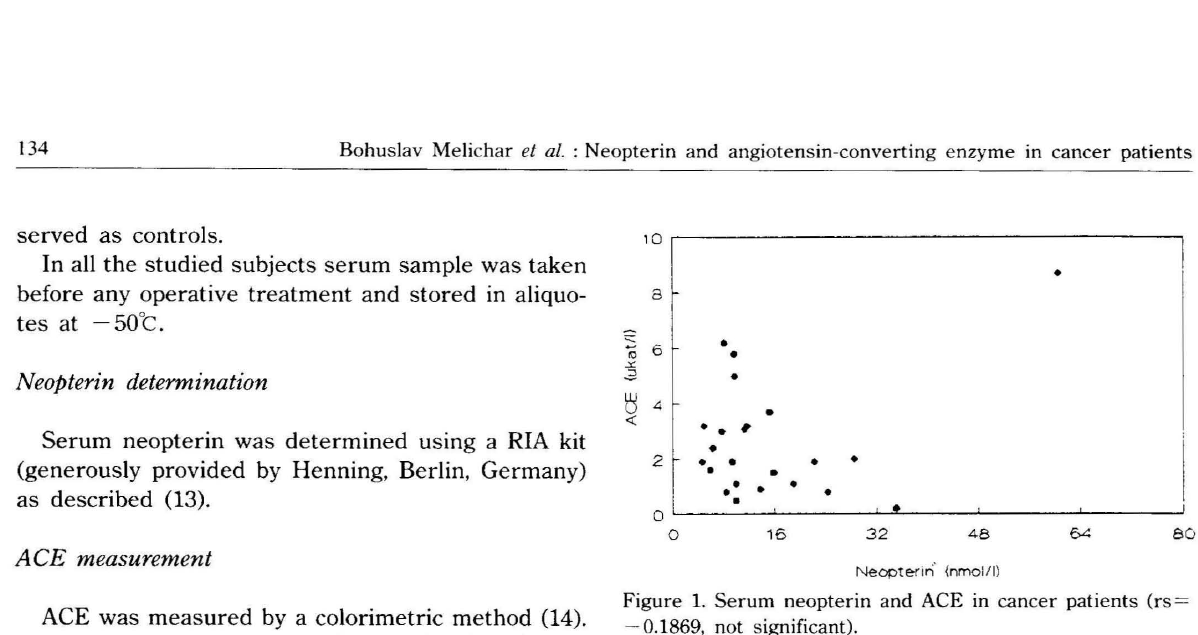
Figure 1. Serum neopterin and ACE in cancer patients (rs= - 0.1869, not